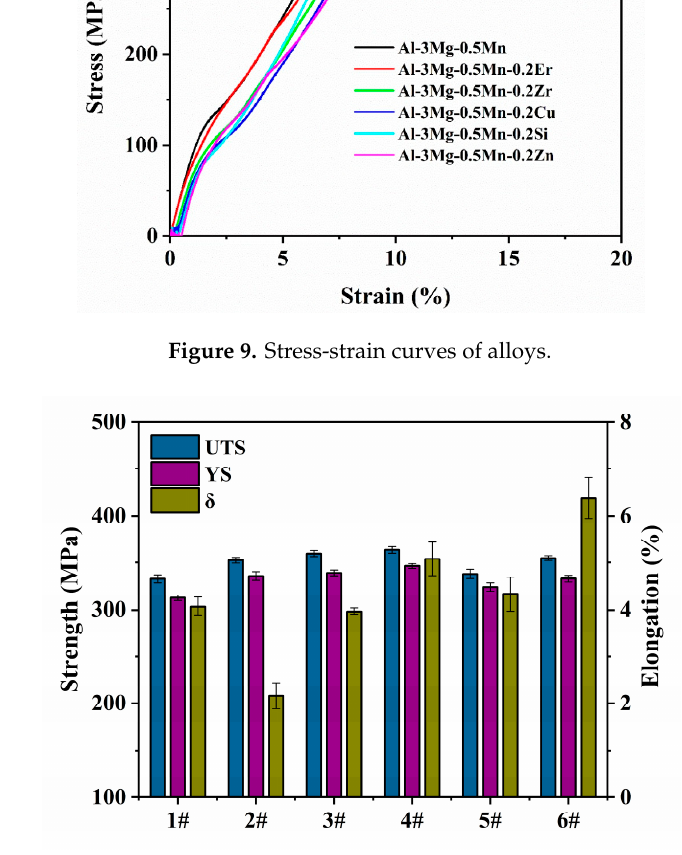
Figure 10. Mechanical properties of cold rolled alloys.